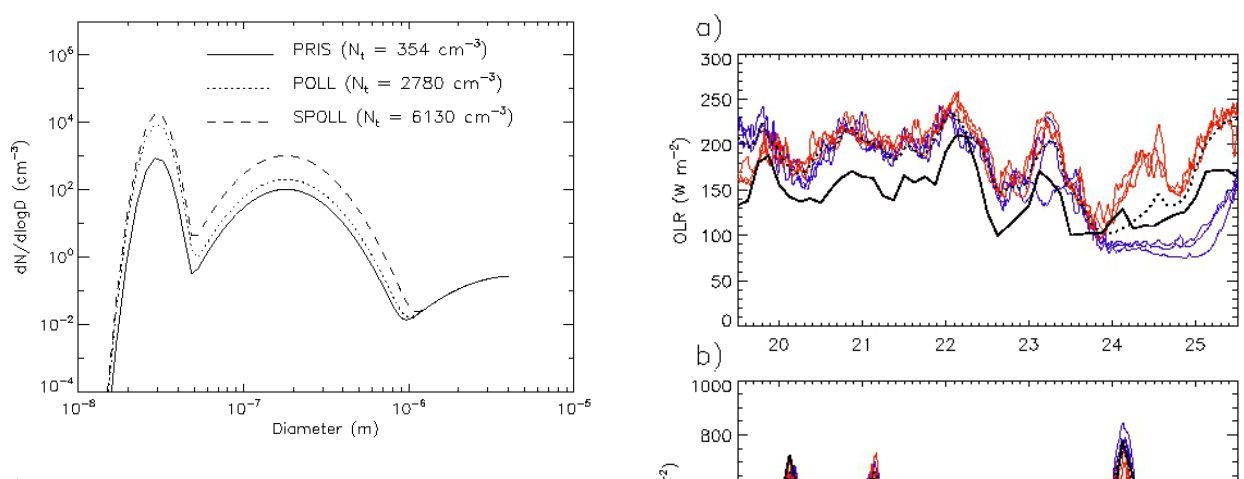
Fig. 1. Specified background aerosol size distributions for the pris- tine (PRIS), polluted (POLL), and highly polluted (SPOLL) simu- lations.